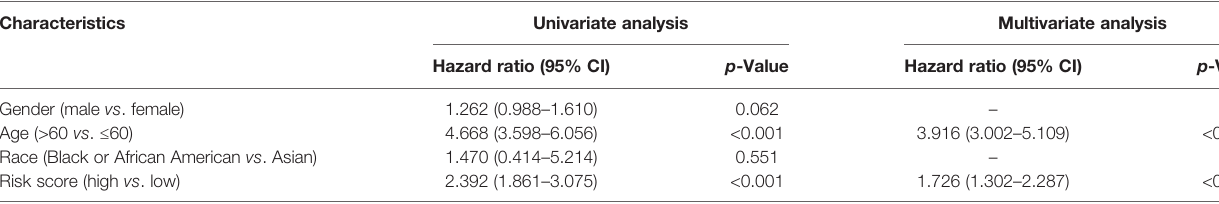
TABLE 3 | Univariate Cox and multivariate Cox regression analyses in derivation cohort.